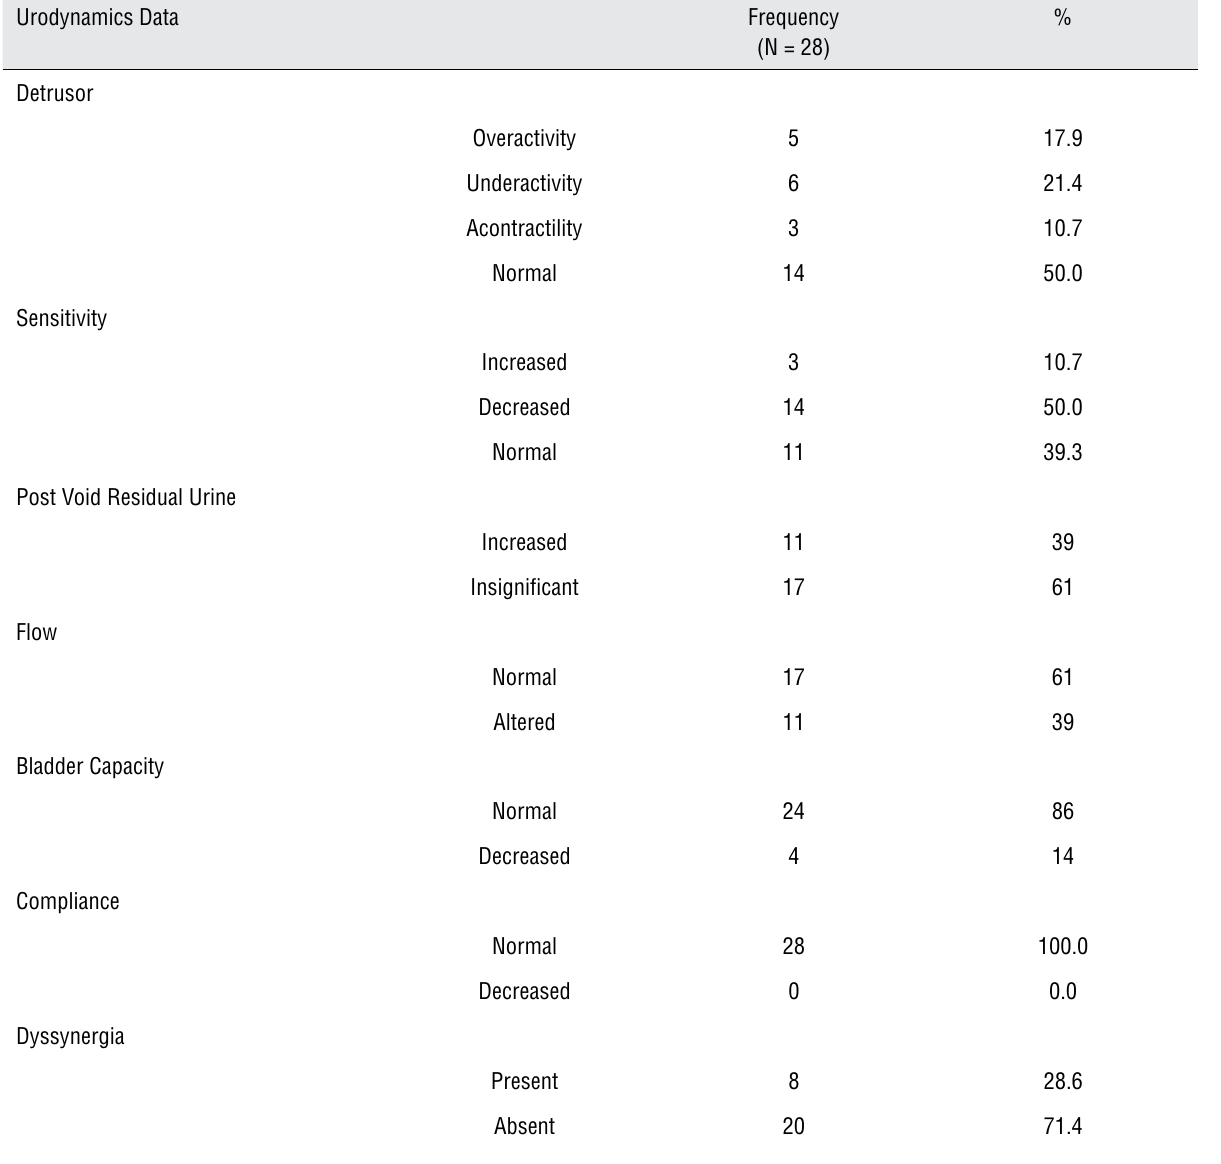
Table 4 - Urodynamics findings in 28 patients with FA. Urodynamics